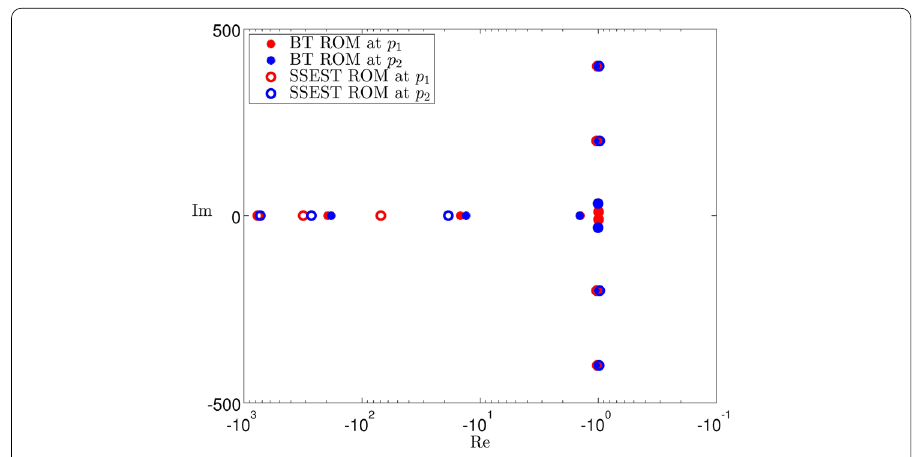
Fig. 10 The poles of the ROM in the pole-residue realization generated by different MOR methods: the balanced trancation (BT) method and the data-driven method “ ssest ” in MATLAB